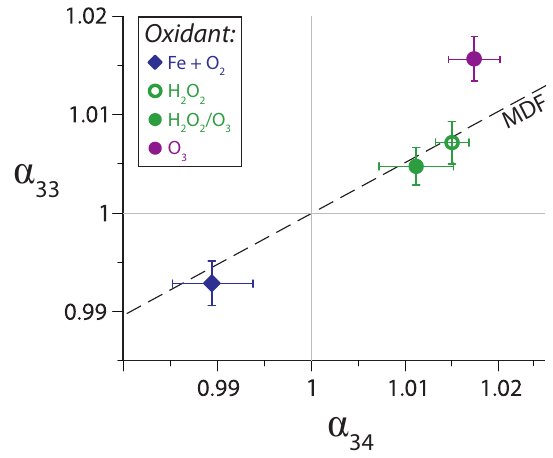
Fig. 5. Fractionation factors at 19 ◦ C for the aqueous oxidation of SO 2 by radical chain reaction initiated by Fe, H 2 O 2 bulk solution (from temperature-dependent regression), and H 2 O 2 /O 3 and only O 3 in aerosol droplets. Error bars are the 1 σ standard deviation and MDF is the mass-dependent fractionation